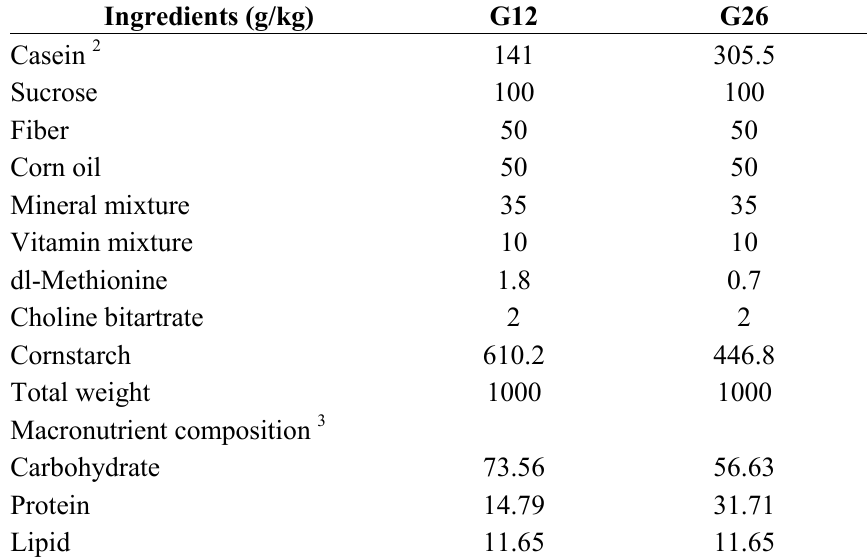
Table 1. Composition of experimental diets 1